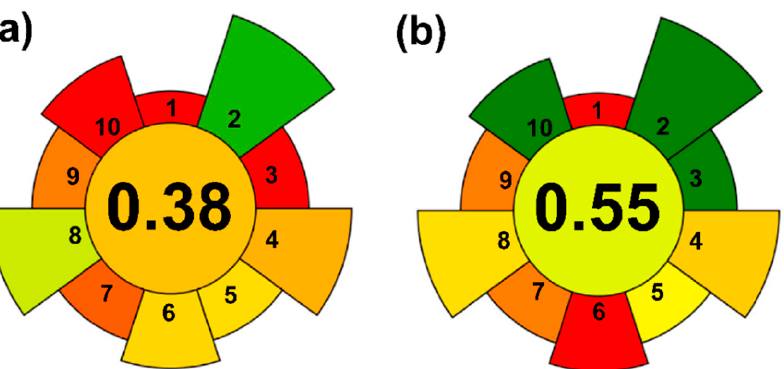
Figure 11. Example of AGREE prep results for phthalate esters preparation by: ( a ) dispersive liquid–liquid microextraction, ( b ) solid phase microextraction. Adapted from Ref. [81].